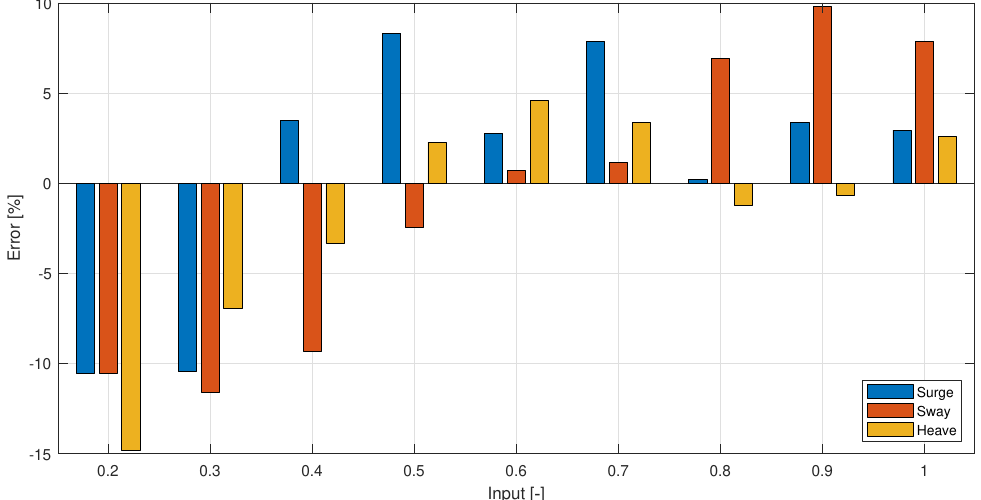
Figure 6. Model and experimental data comparison for surge, sway, and heave. Each of the bars represents a test similar to the one shown in Figure